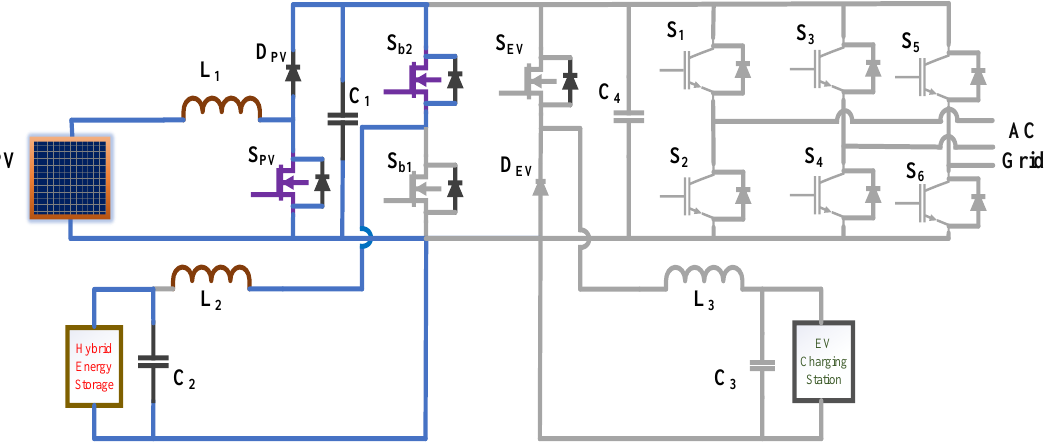
Figure 8. Power flow from PV to HESS. Table 1. EV Charging Operating